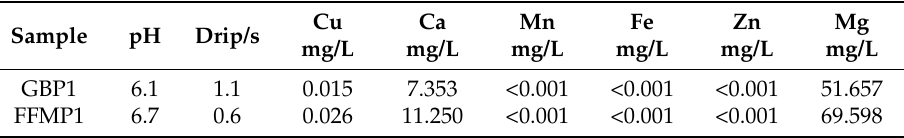
Table 3. Chemical analysis by atomic absorption spectroscopy, average of dripping frequency and pH from cave drip water